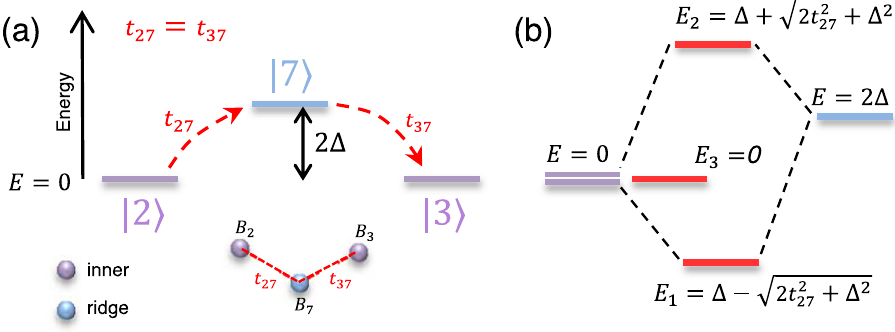
Fig. 3 Effective 3rd neighbor hopping t p via the “ stepping stone ” sites. a Virtual hopping via the ridge site 7 generates an effective hopping t p between 2 and its third neighbor site 3 — i.e. site 3 in the adjacent unit cell in Fig. 2(a). b The odd parity combination of 2 and 3 remains decoupled, but the even parity combination hybridizes with ridge site to gain energy. 2 Δ is difference of atomic on-site energy.